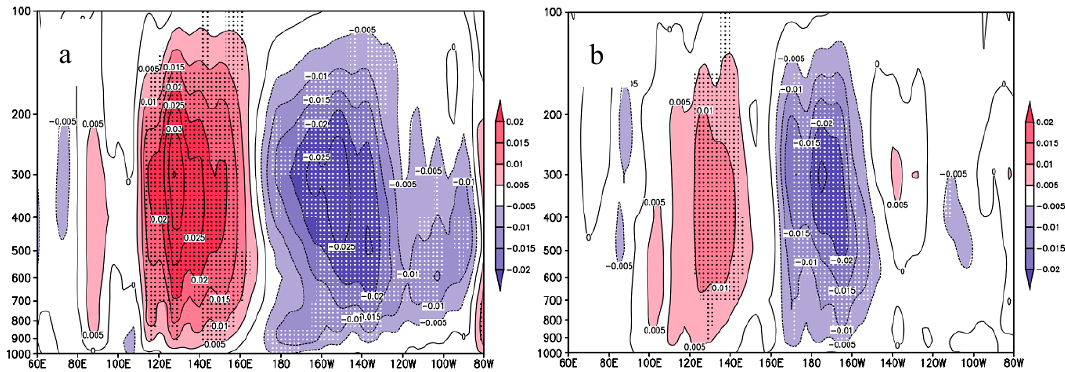
Figure 6. Composite anomalies of longitude–pressure cross-sections of vertical velocity (units: hPa·s − 1 ) averaged along 15° S–15° N during DJF 1980–2017 for ( a ) austral autumn and ( b ) winter El Niño events. Dotted areas indicate statistically significant vertical velocity at the 95% confidence level, based on the Student’s t -test.